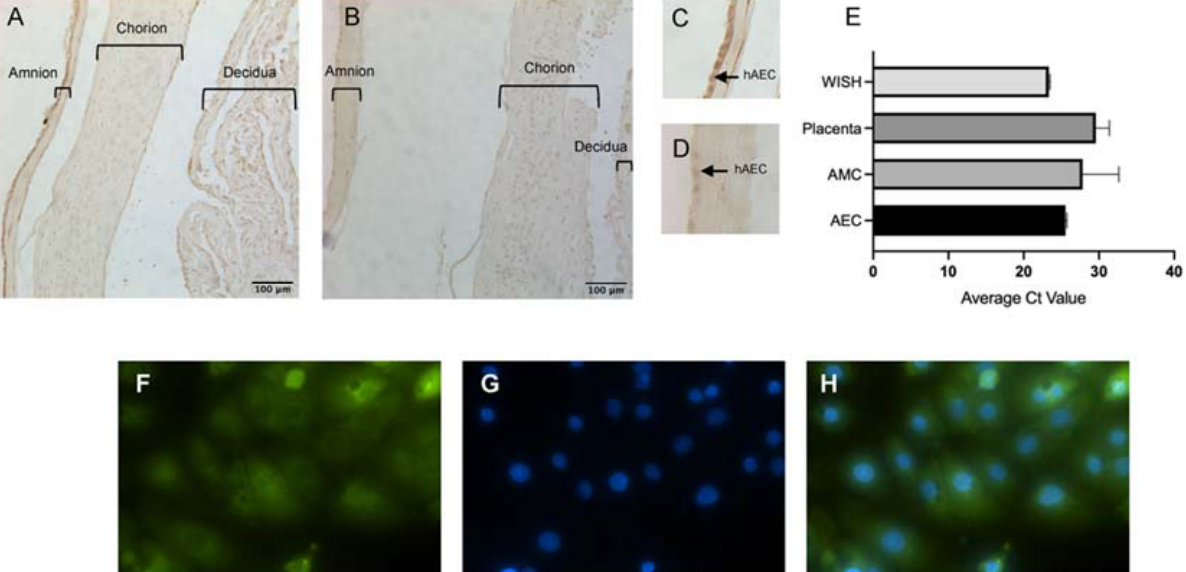
Figure 2. hAECs robustly expressed Nrf2 after human fetal membrane tissue collection and subsequent cell isolation and culture. ( A ) Representative immunohistochemical image of Nrf2 in fetal membranes, magnification 20 × Nrf2 ( B ) IgG control. ( C ) Amnion layer of Nrf2 and ( D ) IgG control stained tissue amnion layer of IgG stained tissue. ( E ) qPCR analysis of Nrf2 expression normalized to GAPDH ( n = 3). Data displayed as mean ± SEM. ( F – H ) Immunocytochemistry of Nrf2 expression in hAECs, magnification 60x FITC-labeled Nrf2, DAPI stain, and merged image, respectively.